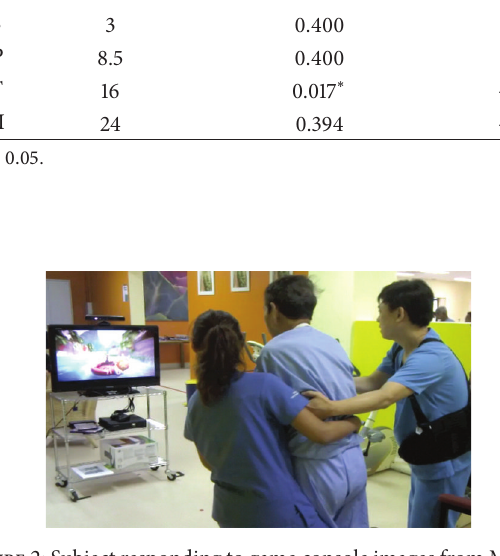
Figure 2: Subject responding to game console images from Micros- oft